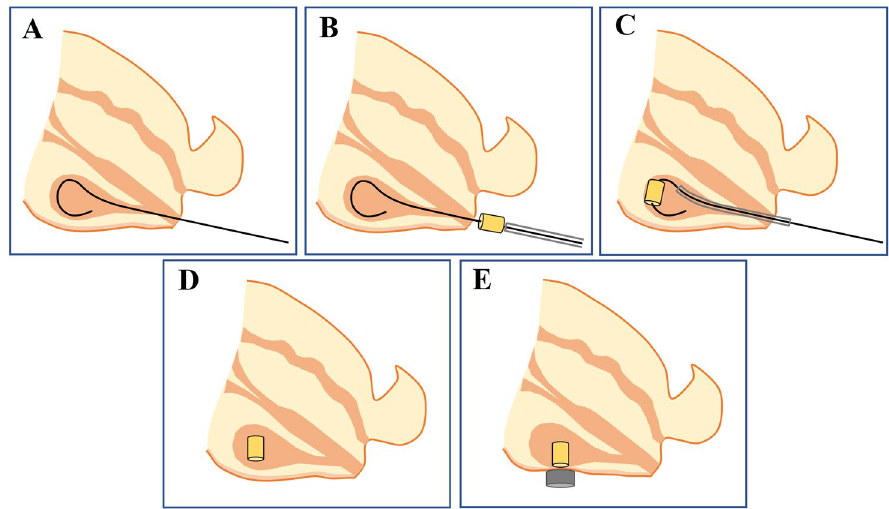
Figure 2. Schematic illustration of the surgical procedure. ( A ) The guide wire was inserted through the urethra into the bladder. ( B ) The daughter magnet and scalp needle tube were inserted through the end of the guide wire. ( C ) The daughter magnet was pushed along the guide wire into the bladder by pushing the scalp needle tube. ( D ) The guide wire and the scalp needle tube were removed. ( E ) After placing the parent magnet on the abdominal wall, the two magnets attract each